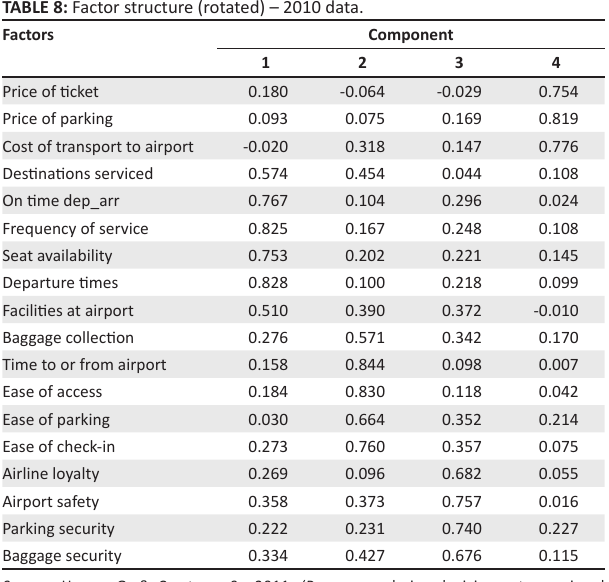
TABLE 8: Factor structure (rotated) – 2010